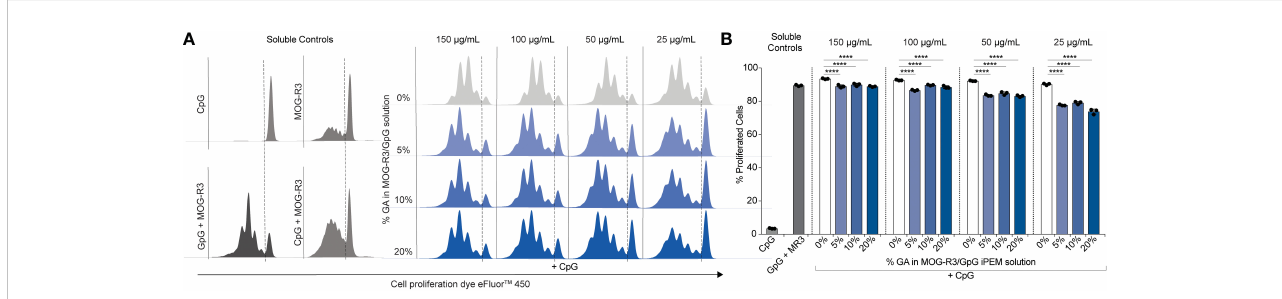
FIGURE 5 Cross-linked iPEMs induce 2D2 T cell proliferation. (A) Representative histograms of T cells analyzed by fl ow cytometry. Dotted line separates undivided cells from divided cells. (B) Percent of live proliferated CD4+ T cells in culture after treatment with iPEMs. Data represents mean ± standard deviation. Statistical analysis performed using two-way ANOVA followed by Dunnett ’ s test comparing non-cross-linked iPEMs to cross-linked groups. ****p <